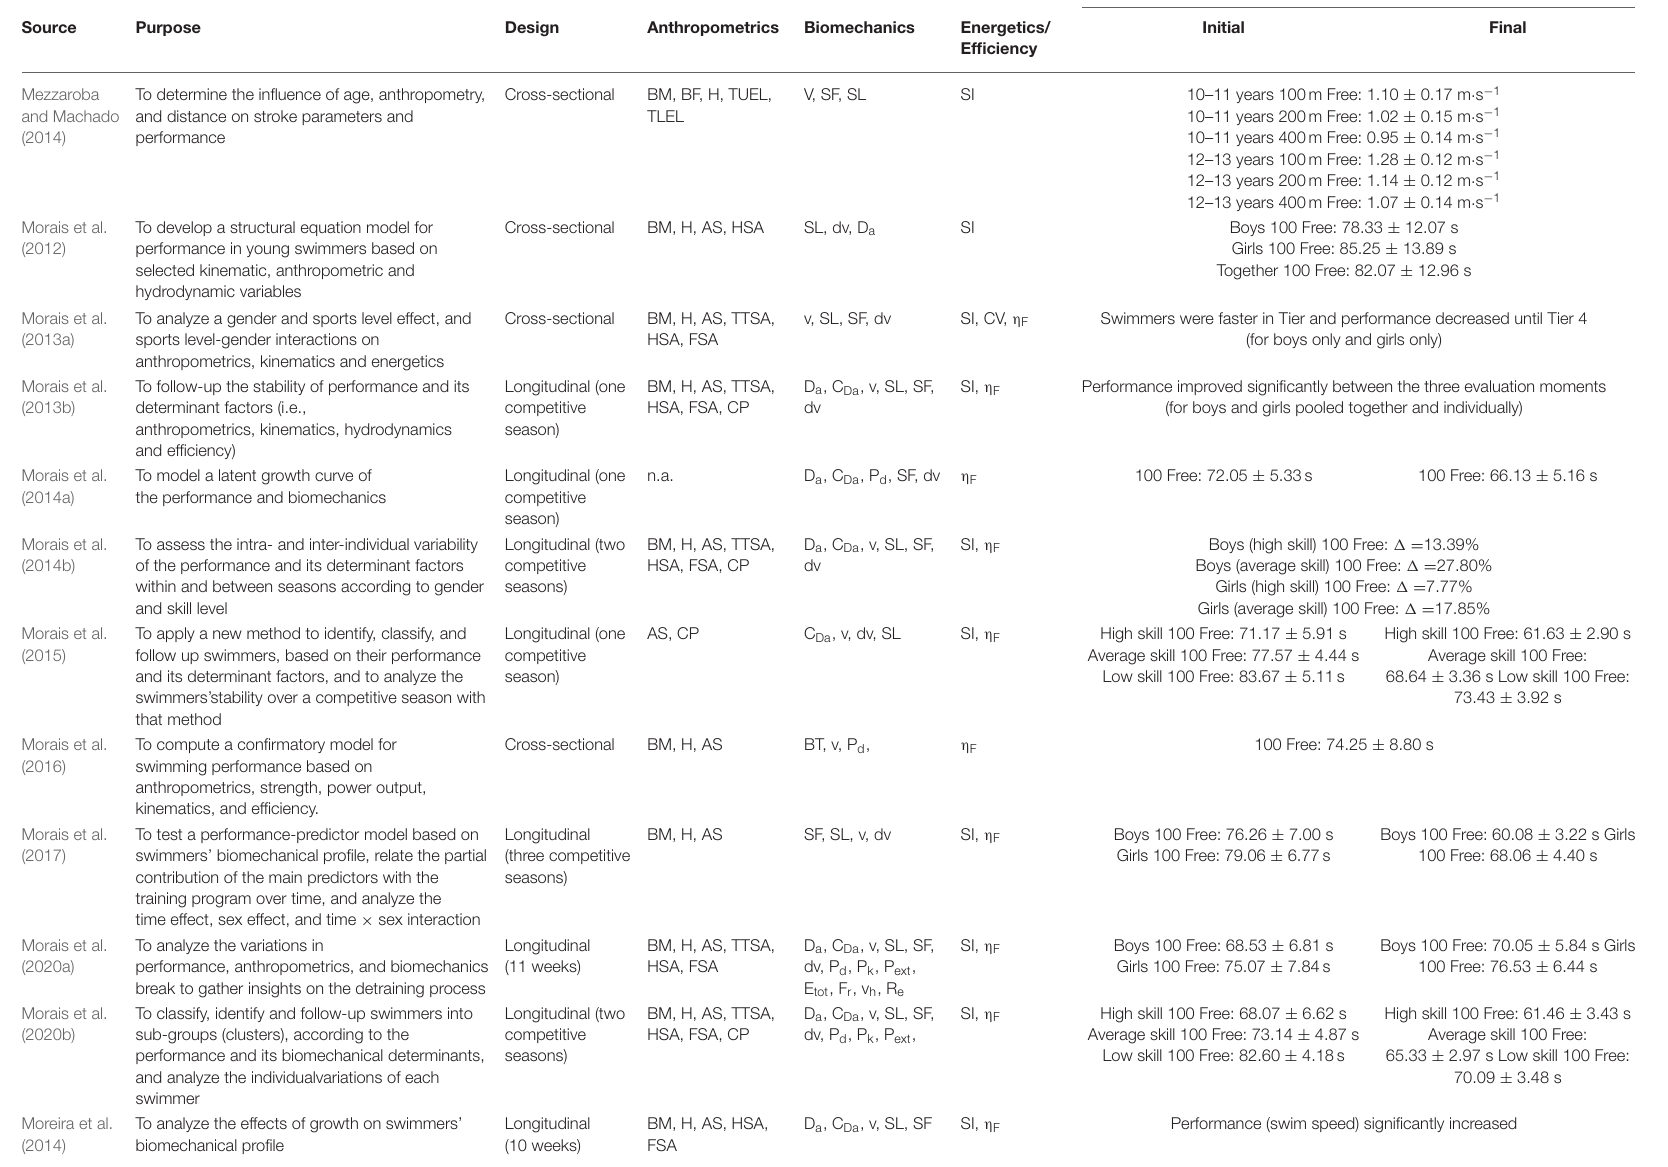
Swimmers were faster in Tier and performance decreased until Tier 4 (for boys only and girls